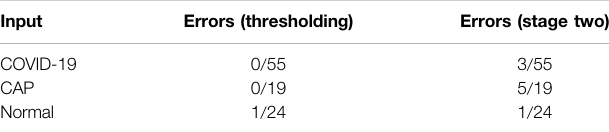
TABLE 6 | The number of the mis-classi fi ed cases for each type of the input disease and the number of cases that were not identi fi ed correctly by. the 3 %